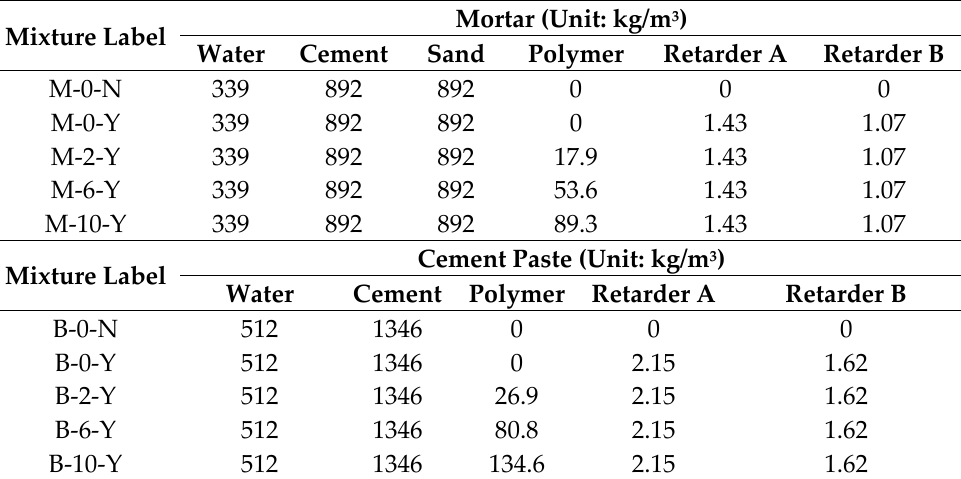
Table 1. The mix proportions of the tested mortars and cement pastes.